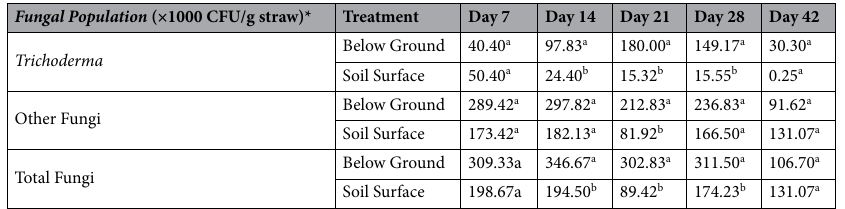
Table 1. Effect of placement on the fungal populations in the litterbags for each sampling period. *Means with the same letter are not significantly different ( p < 0.05).